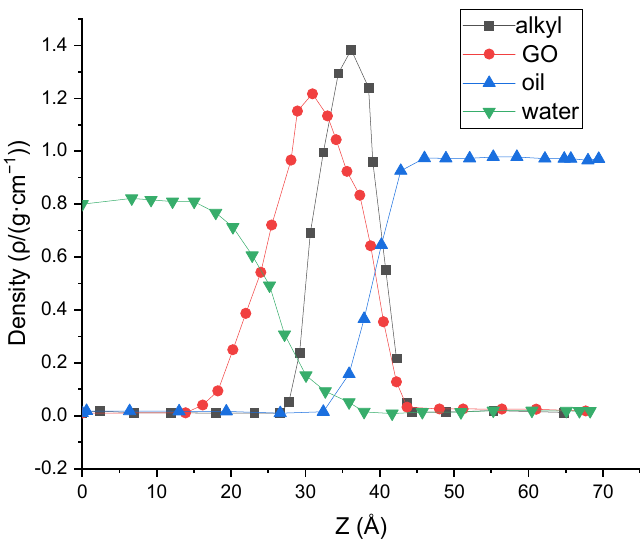
Figure 7. The density of the components in the oil–water and nanoparticle NGO systems.